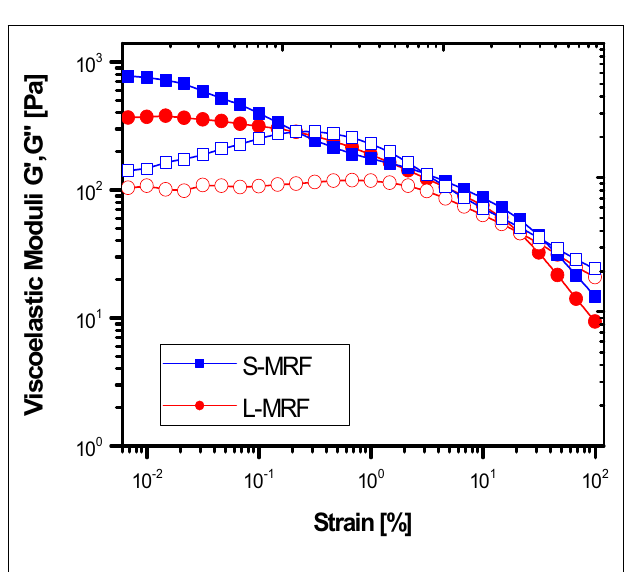
FIGURE 4 |Amplitude sweep test for S-MRF and L-MRF samples at magnetic field strength H = 30.97kAm − 1 (filled symbol G (cid:48) , open symbol G (cid:48)(cid:48) )